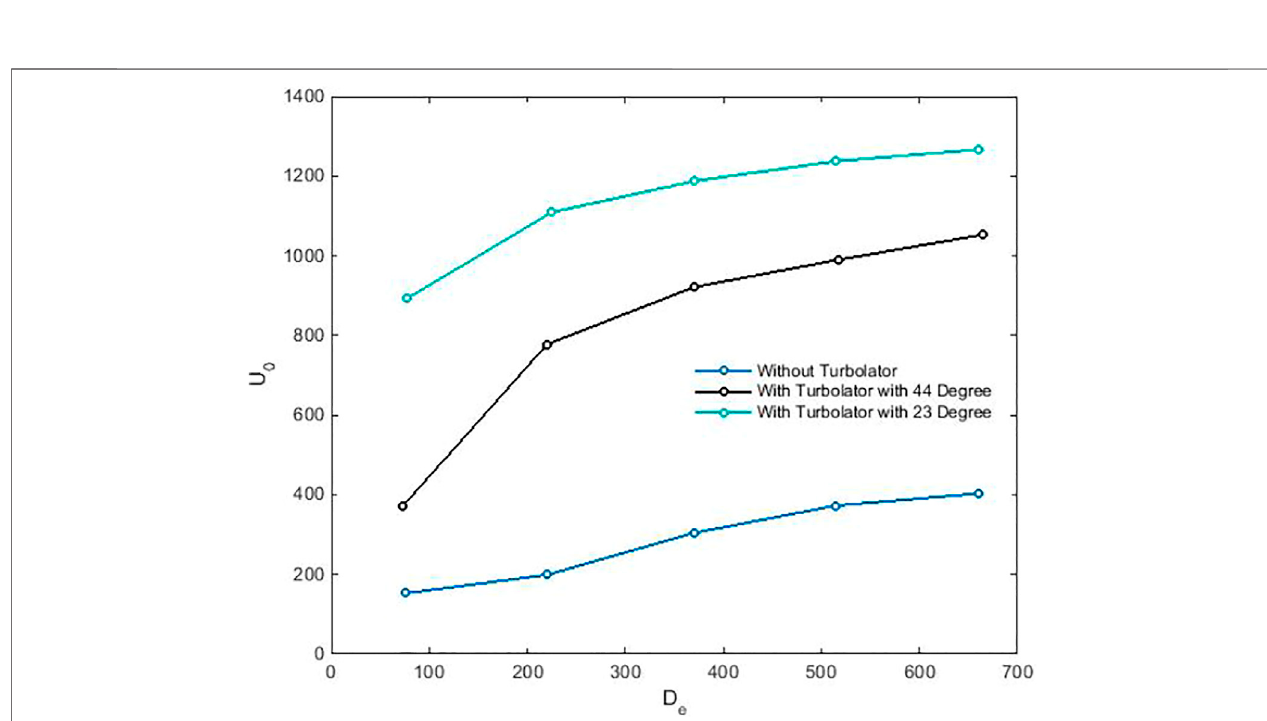
FIGURE 10 | The comparison between the heat exchanger without Turbolator and heat exchangers with optimized and speci fi c turn of Turbolator.